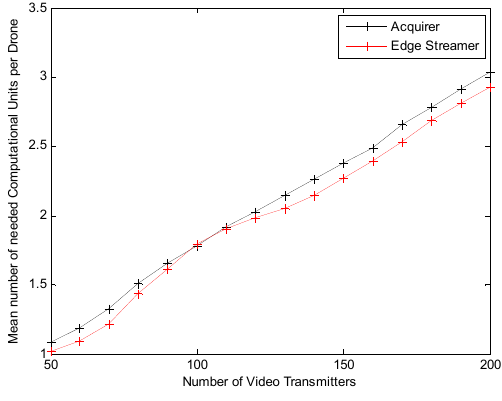
Figure 7. Computation units needed per drone.